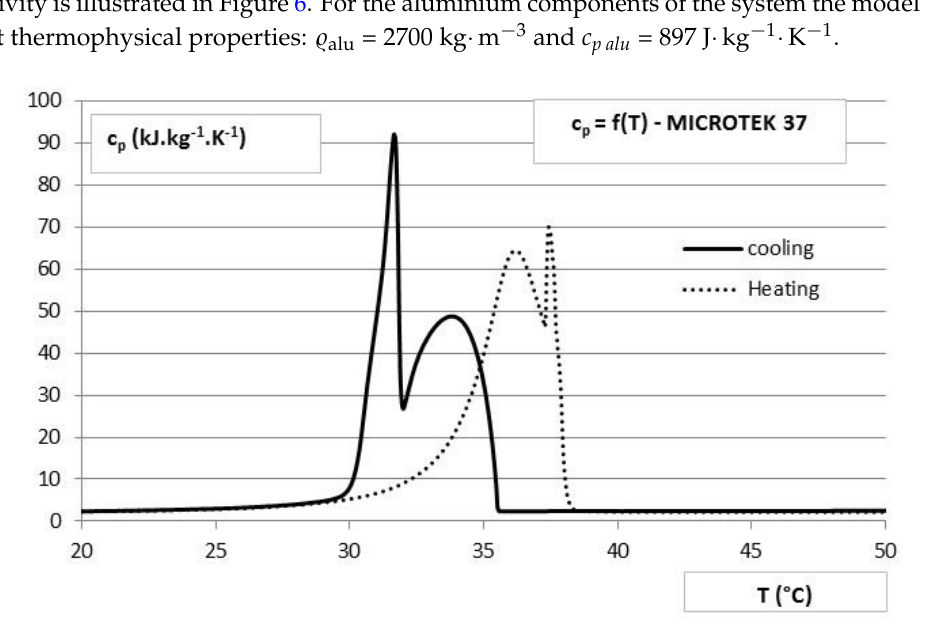
Figure 5. Equivalent heat capacity of the Microtek 37 from DSC (Differential Scanning Calorimetry) measurement.